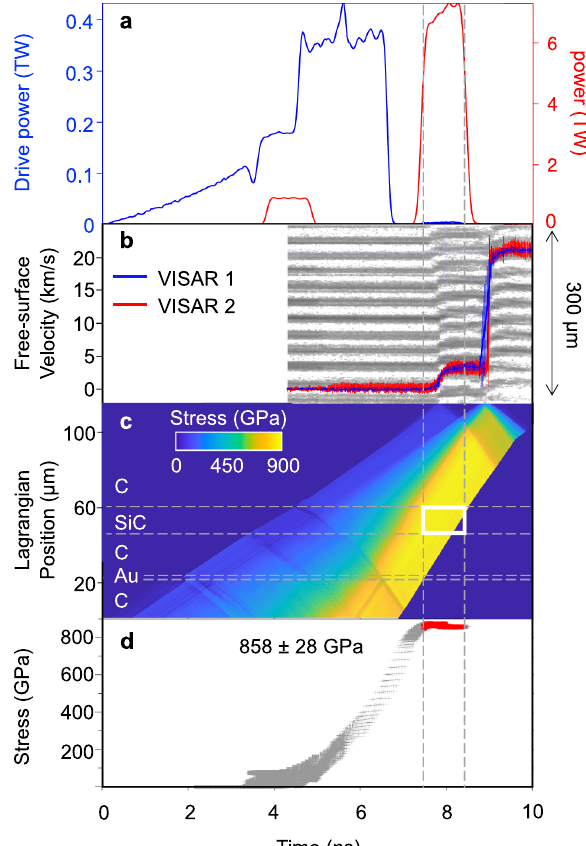
Fig. 4 Timing and stress determination for SiC ramp-compression experiment (diamond window). a Drive laser pulse for shot #98955 (blue trace). X-rays are generated using a pair of 1-ns square pulses (red trace). b Raw interferogram from VISAR records diamond free-surface velocity that is used to determine the stress history. c Calculated map of stress distribution within the target assembly as a function of time determined by the backward characteristics analysis (see Methods). The horizontal dashed lines represent the material layers in Lagrangian coordinates. d Calculated stress history of the SiC sample as a function of time. The vertical dashed lines represent stress states over the X-ray probe period.